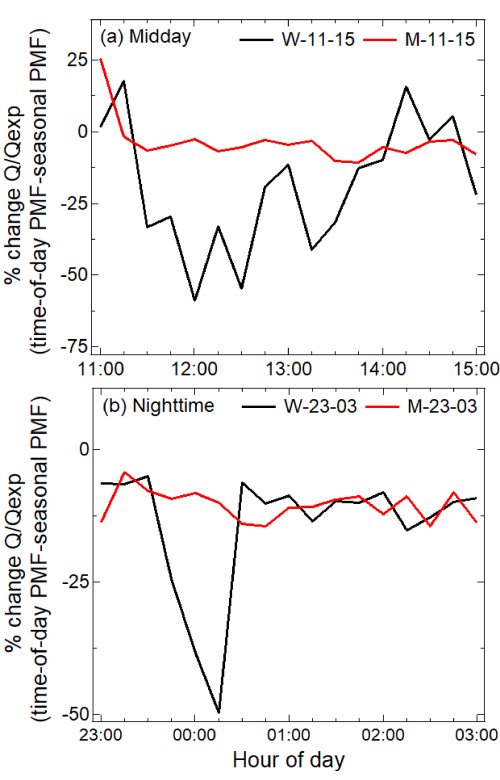
Figure 9. Percent change of 15min averaged seasonally represen- tative Q/Q exp values between the seasonal PMF approach and the time-of-day PMF approach in (a) midday and (b) nighttime periods. Time-of-day PMF selectively improves Q/Q exp in specific periods compared to the seasonal PMF